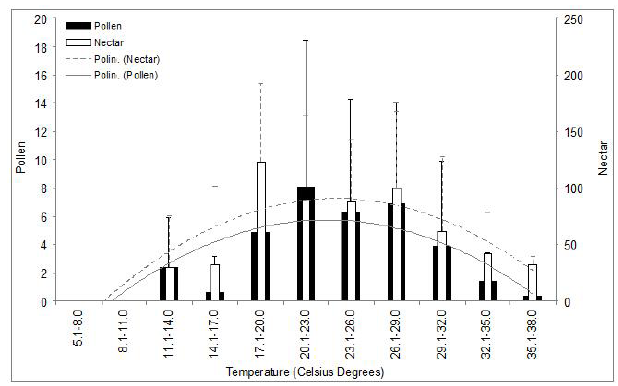
Fig 3 . Hourly variation of pollen and nectar collection related to the meteorological factors (temperature and relative humidity). Solid and dashed bars represent standard deviation of pollen and nectar collection,